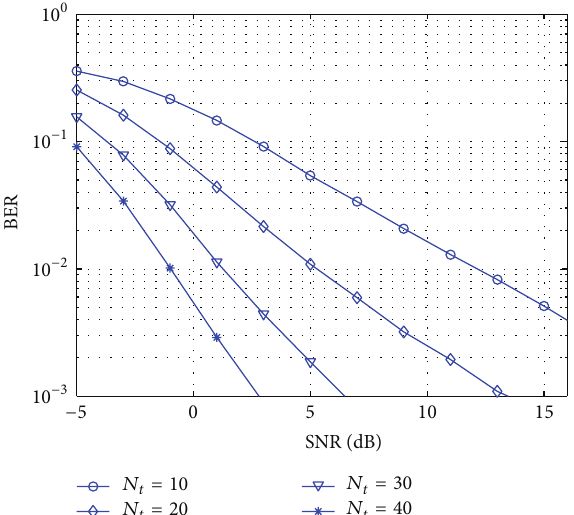
Figure 6: BER of subchannel selection method and zero-padding method with massive BSTx antennas ( 𝑁 𝑡 = 50 ), 𝐾 = 5 , for 16-QAM